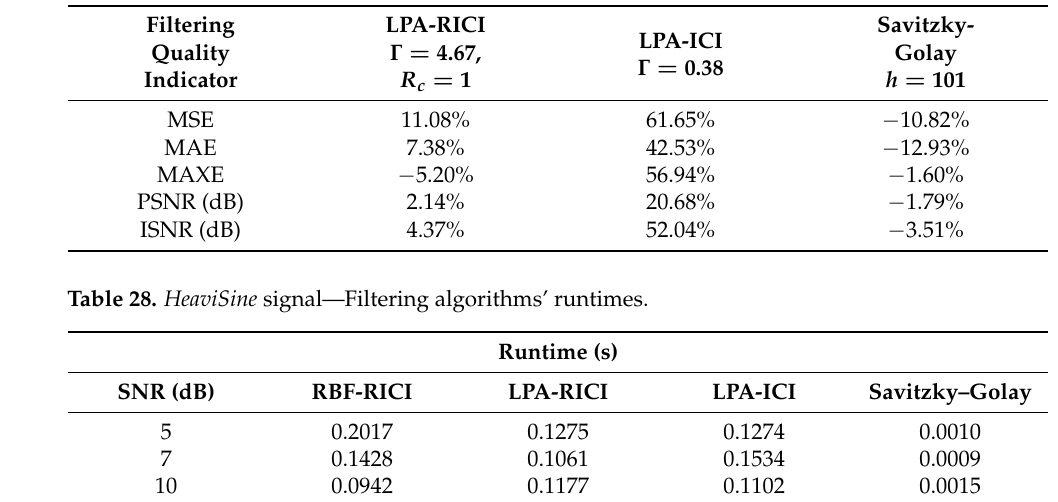
Table 27. HeaviSine signal (SNR = 10 dB)—Filtering quality improvement of the RBF-RICI-based filtering over other tested algorithms.